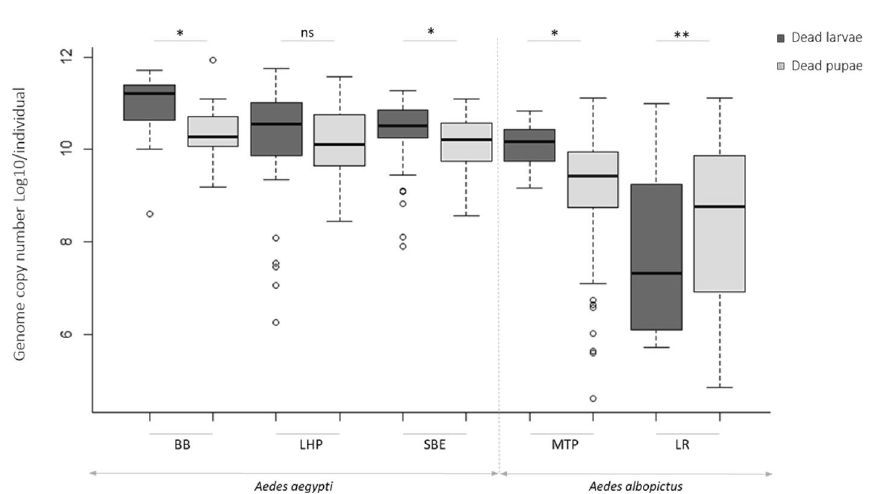
Figure 2. Viral dose in dead larvae or pupae of AalDV2-infected mosquitoes for each tested strain of Ae. aegypti (LHP, Long-Hoà, BB, Bora-Bora and SBE, Benin) and Ae. albopictus (MTP, Montpellier and LR, La Réunion). Larvae (N = 3 replicates of 150 larvae per experimental condition) were infected, or not, with 3 × 10 11 veg/ml of AalDV2. Viral doses of dead larvae and dead pupae are expressed as log 10 of the number of AalDV2 genomes quantified (gev) by qPCR in each individuals. Wilcoxon W test was used to compared virus titer in larvae compared to pupae for each strain. ***p-value < 0.001; *p-value < 0.05; n.s., not statistically